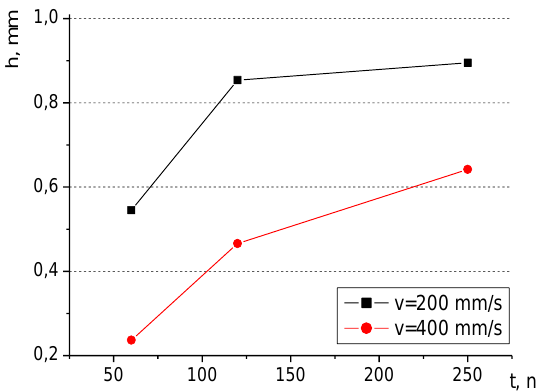
Figure 8. Relationship between pulse duration and groove depth for two scanning velocities.